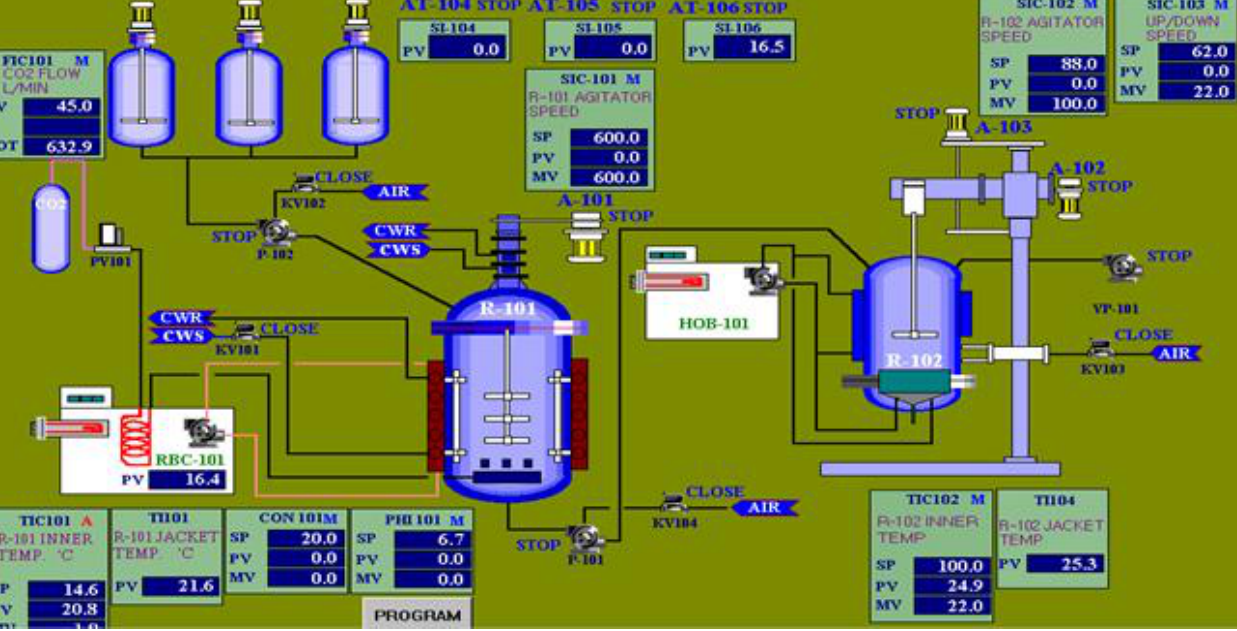
precipitated at various 3